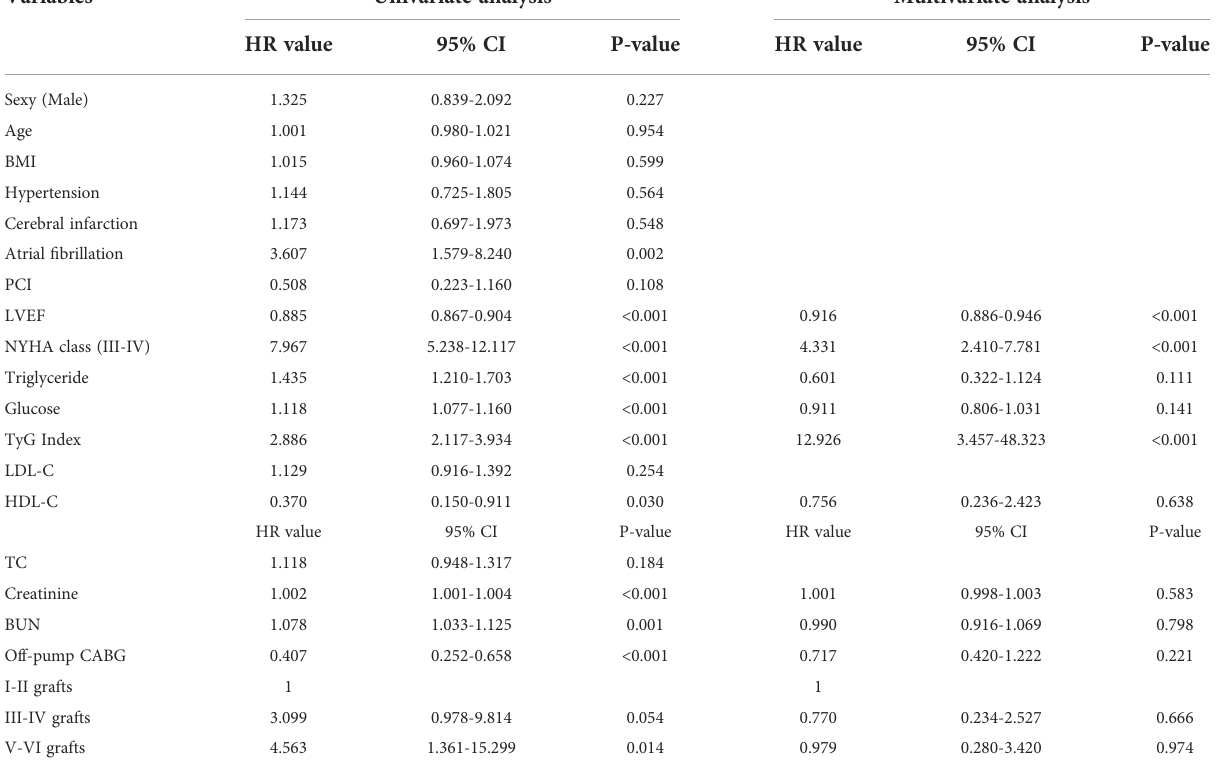
TABLE 3 Univariate and multivariate analyses of MACE in T2DM patients with CABG